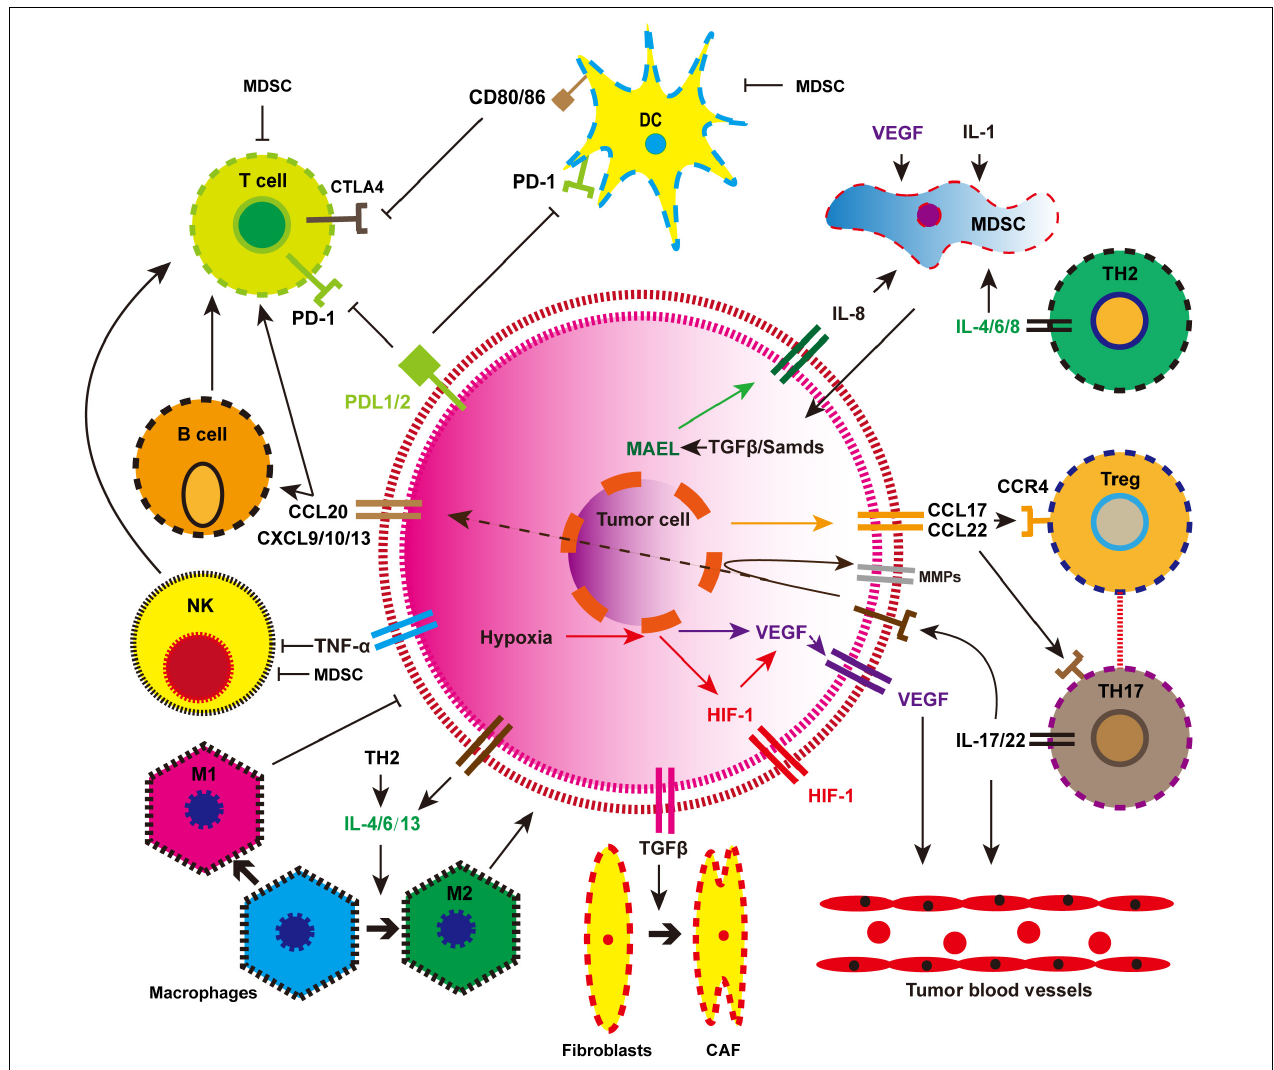
FIGURE 2 | The immune landscape of esophageal cancer. MDSC, myeloid-derived suppressor cell; DC, mature dendritic cell; NK, natural killer cell; Treg, regulatory T cell; M1, tumor suppressor macrophages; M2, tumor-promoting macrophages; CAF, cancer-associated